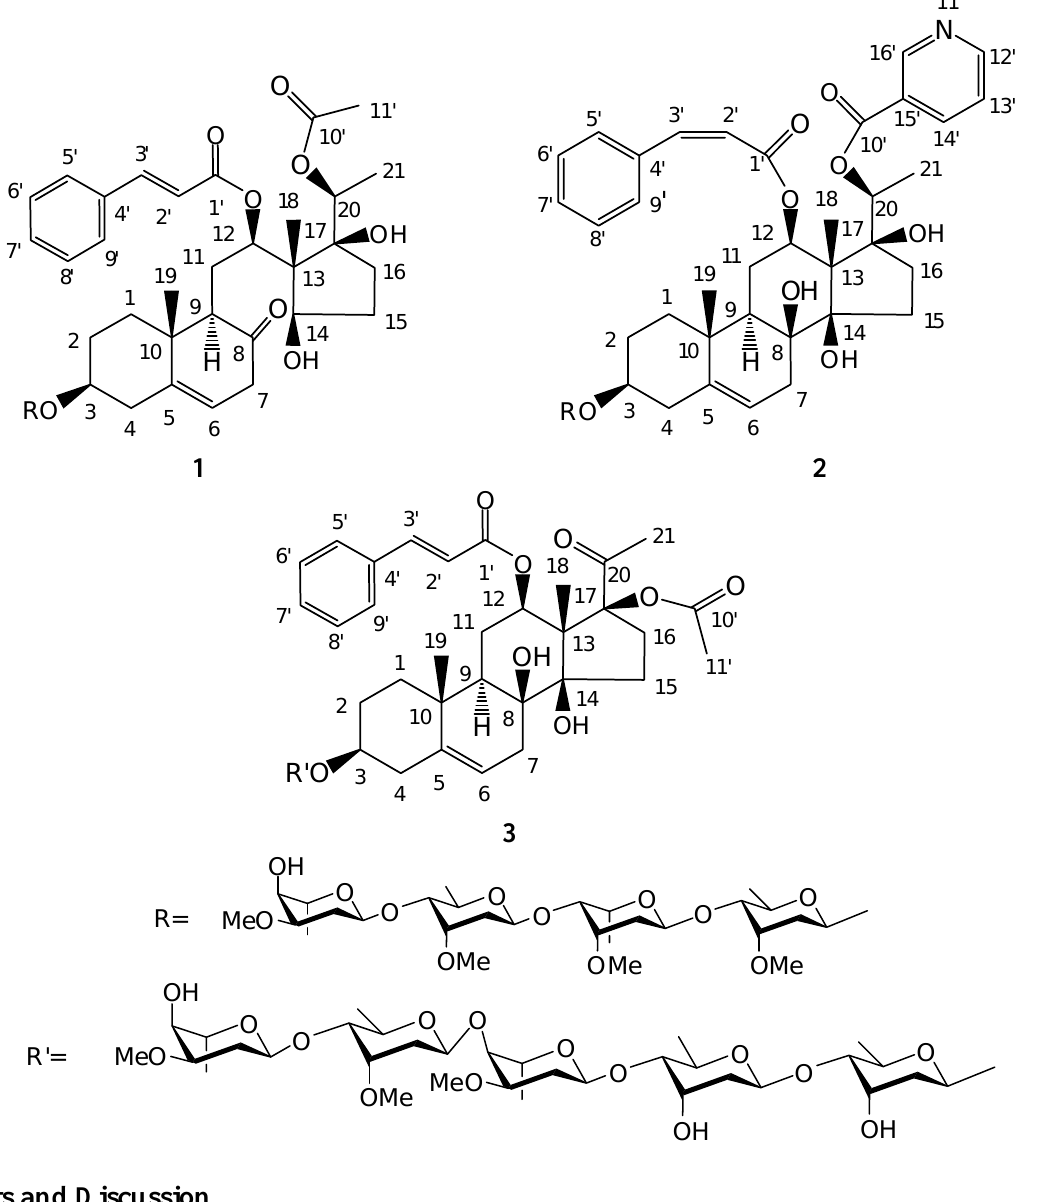
Figure 1. Structures of new compounds 1 – 3